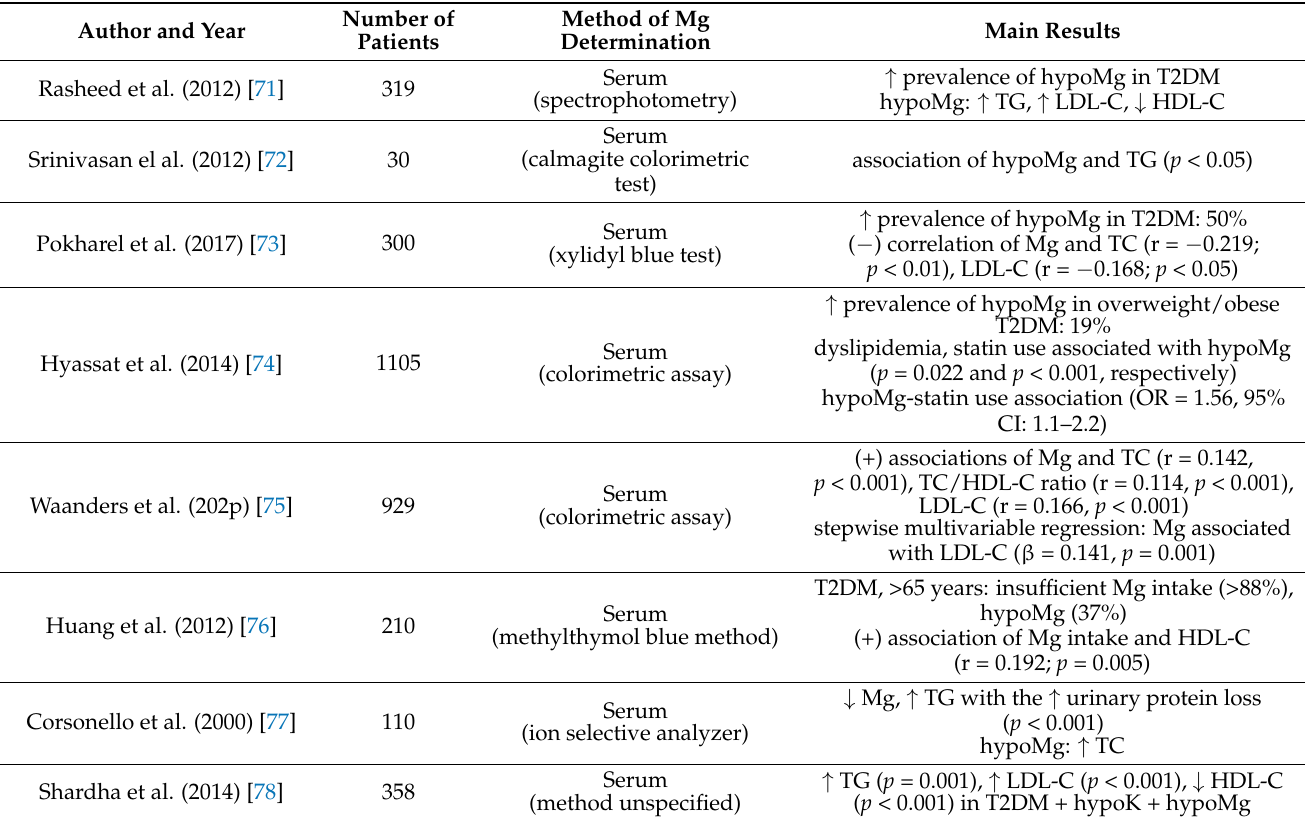
Table 4. Interplay of hypomagnesemia and